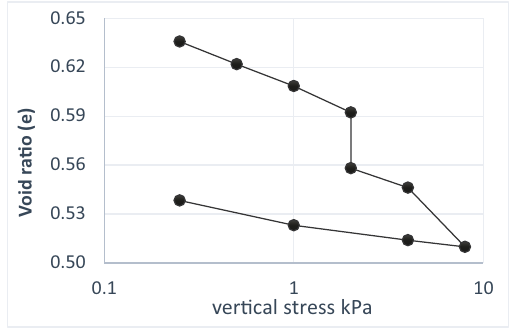
Figure 7: Collapse test results for soil treated with 10, 20, and 30% cement